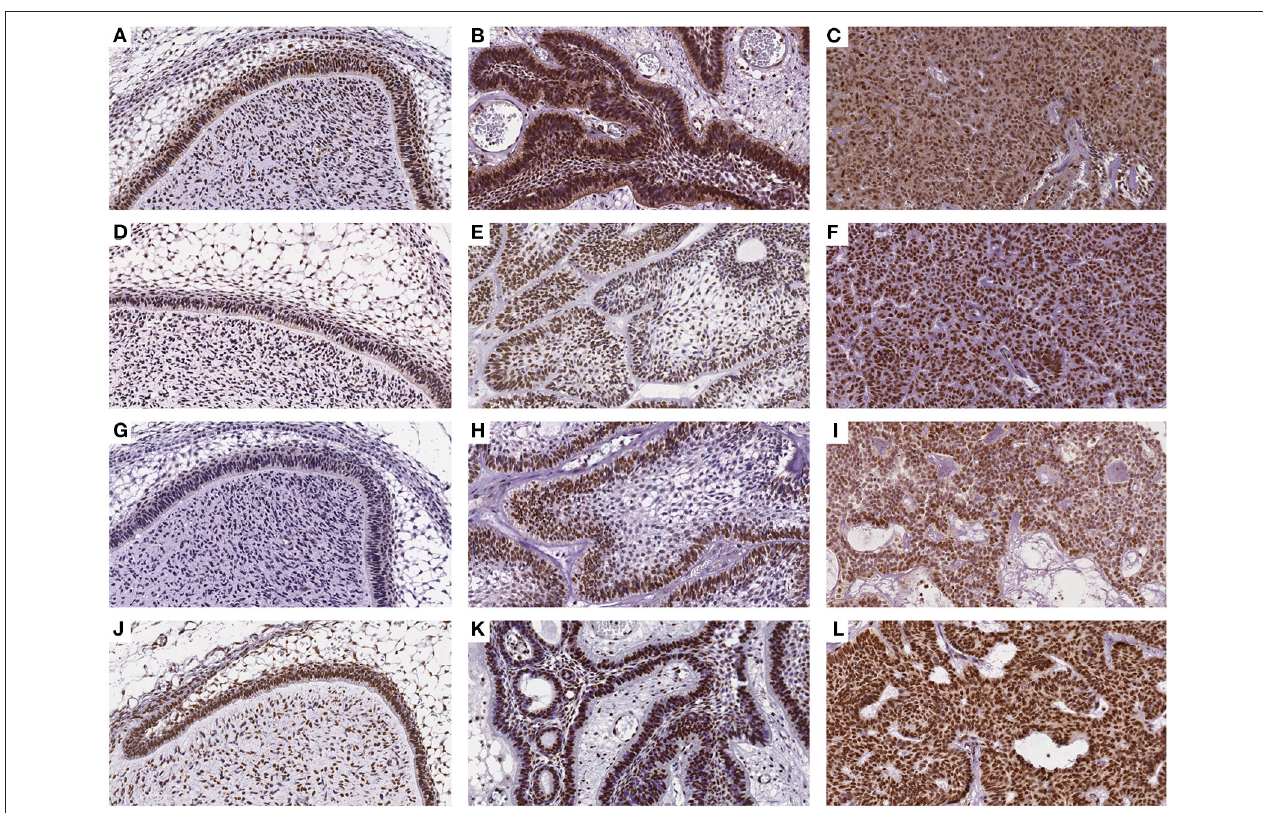
FIGURE 1 | Immunohistochemical reaction for DNMT1, DNMT3A, DNMT3B, and H3K9ac antibodies in DF (A,D,G,J) , AME (B,E,H,K), and AC samples (C,F,I,L) , respectively. (DAB, 200 ×